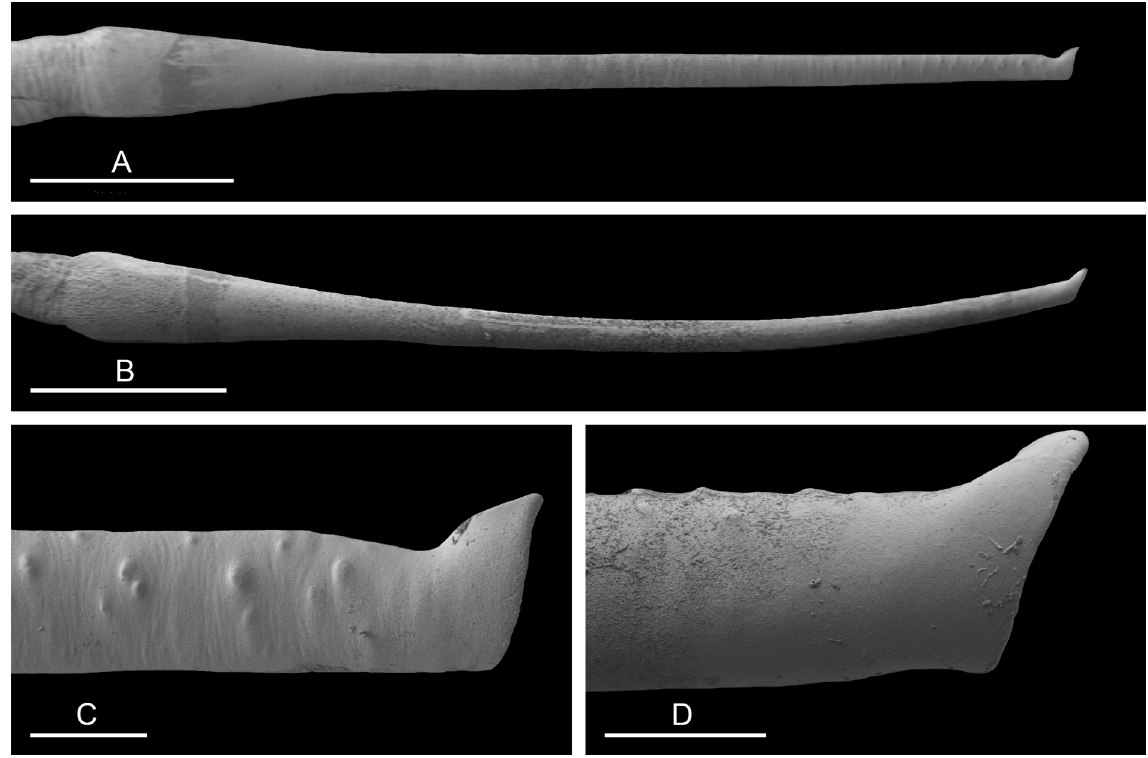
Fig. 29. Paromoionchis daemelii (Semper, 1880) comb. nov., spine of accessory penial gland. A . Australia, New South Wales [1519] (AM C.468917.001). B . Australia, New South Wales [1521] (AM C.468919.001). C . Distal tip of spine, same as A. D . Distal tip of spine, same as B. Scales: A–B = 500 μm; C–D = 50